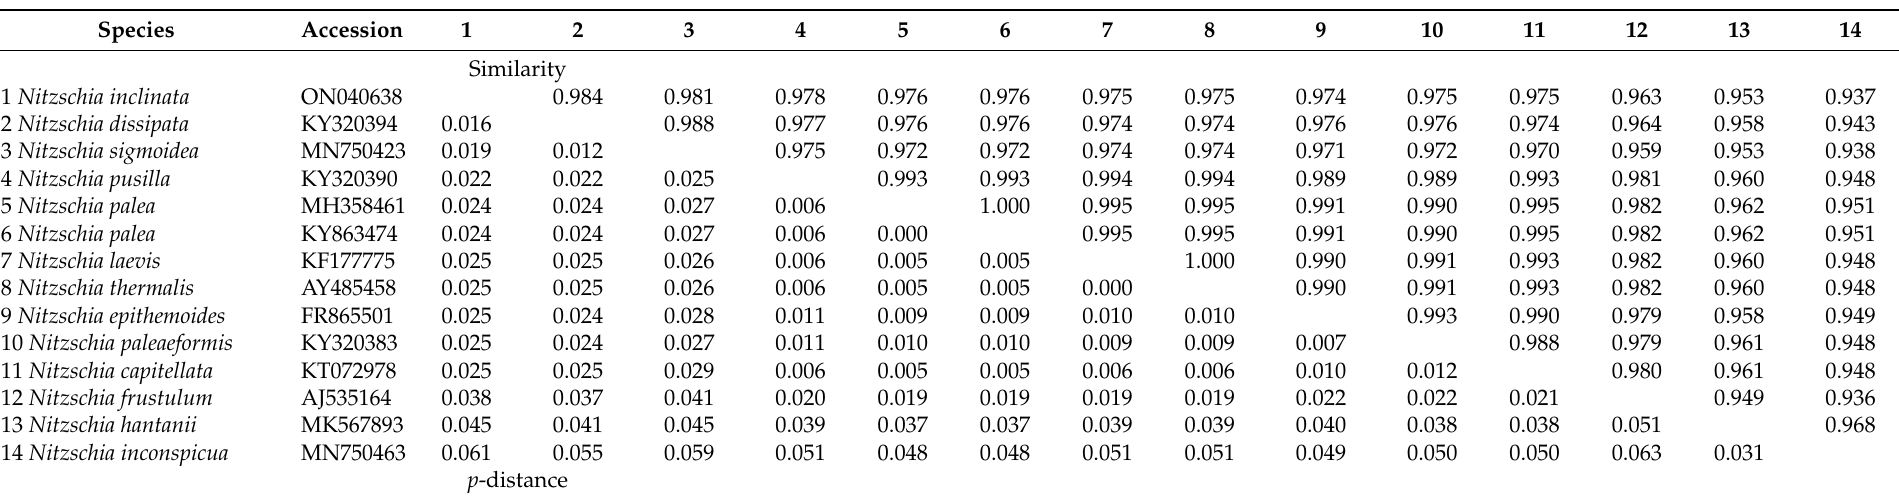
Table 9. Similarity scores and genetic distances among 14 aligned sequences (1392 bp) of Nitzschia species based on SSU rRNA